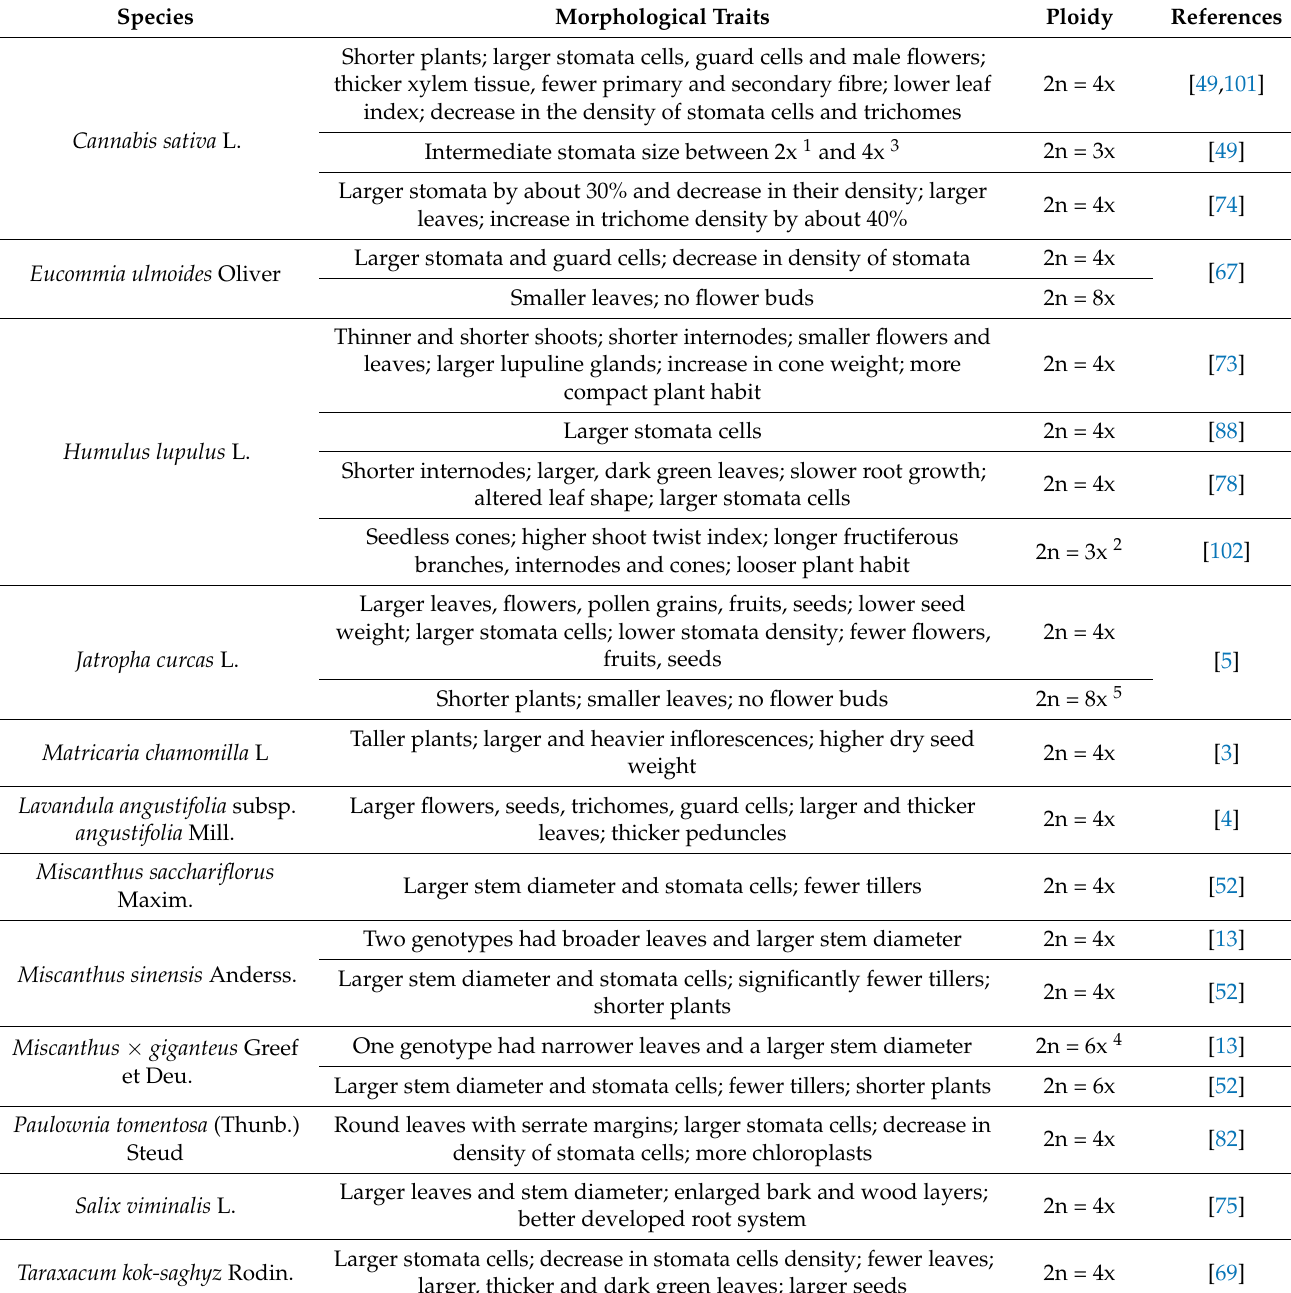
Table 3. The effect of polyploidisation on morphological traits of selected industrial plants. Species Morphological Traits